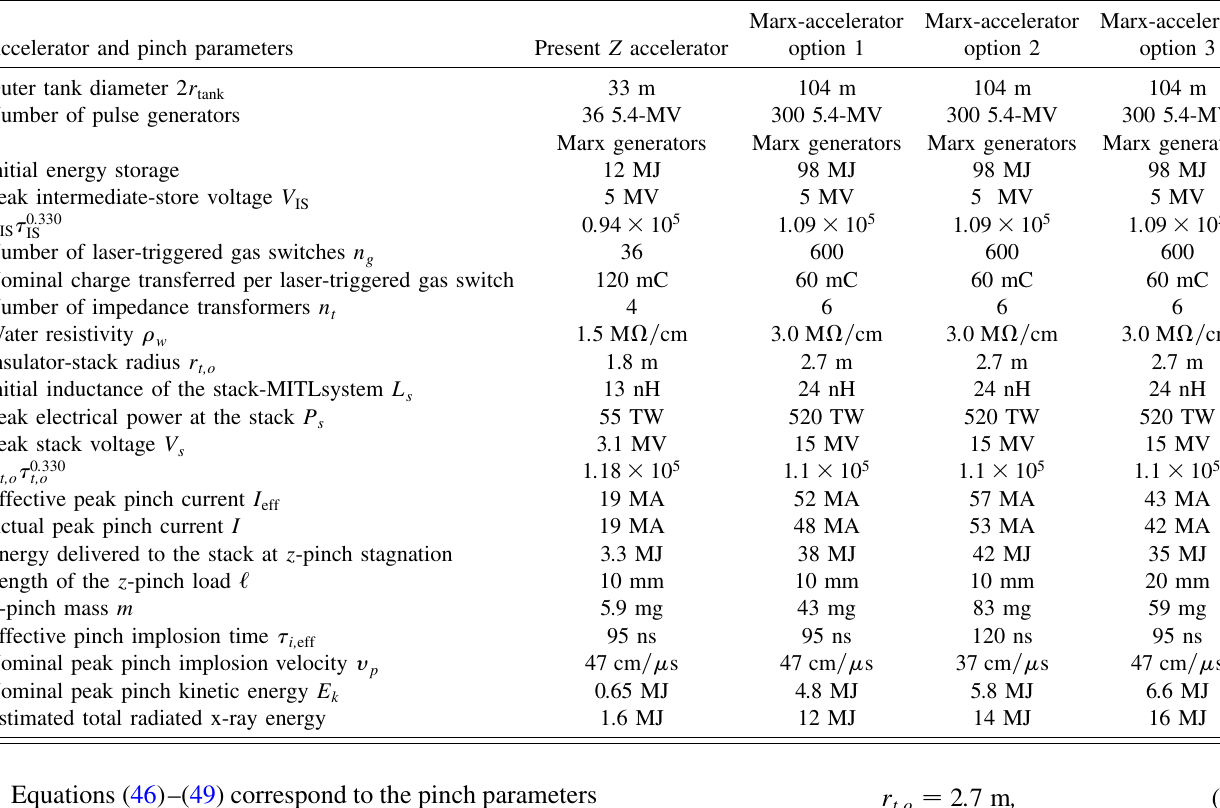
Peak intermediate-store voltage V IS